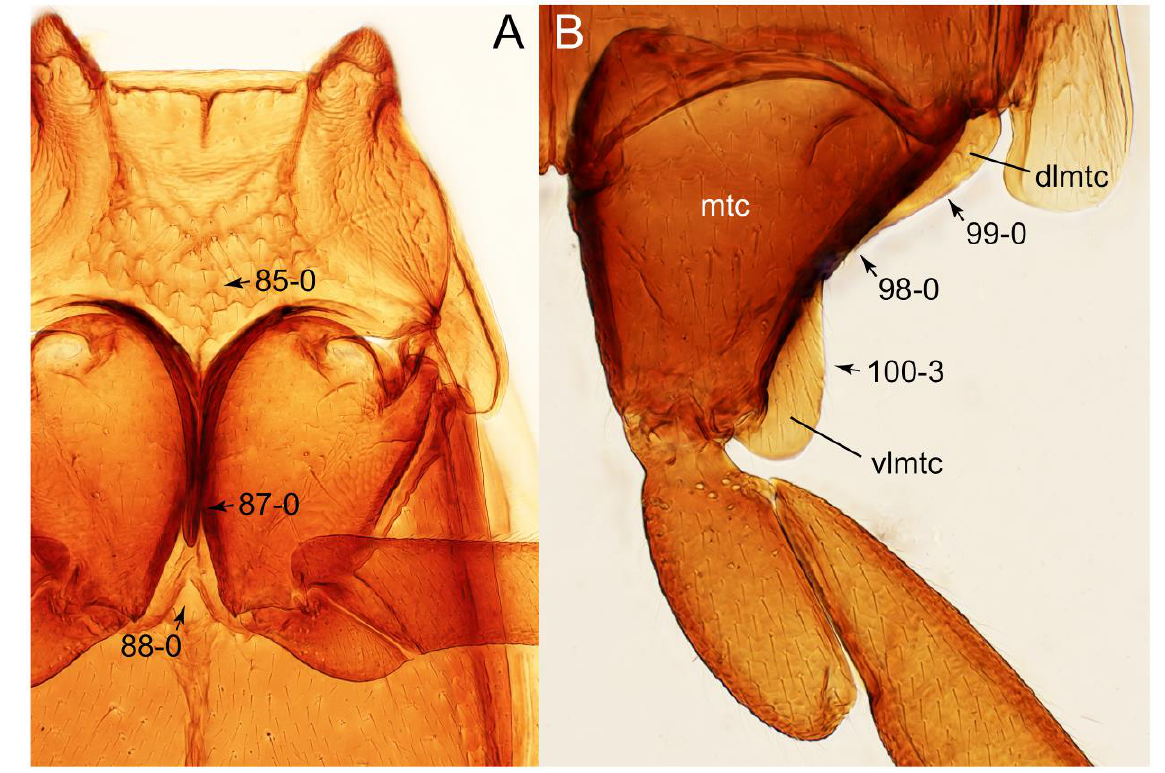
Figure 46. Photographs of body parts of Deropini ( Derops ), enlarged. ( A ) mesothorax and metathorax of Derops longicornis , ventral view. ( B ) left metacoxa of Derops longicornis , ventral view. Abbreviations: dlmtc, dorsal lamella of metacoxa; mtc, metacoxa; vlmtc, ventral lamella of metacoxa. Characters and character states (format X-X) are indicated on each